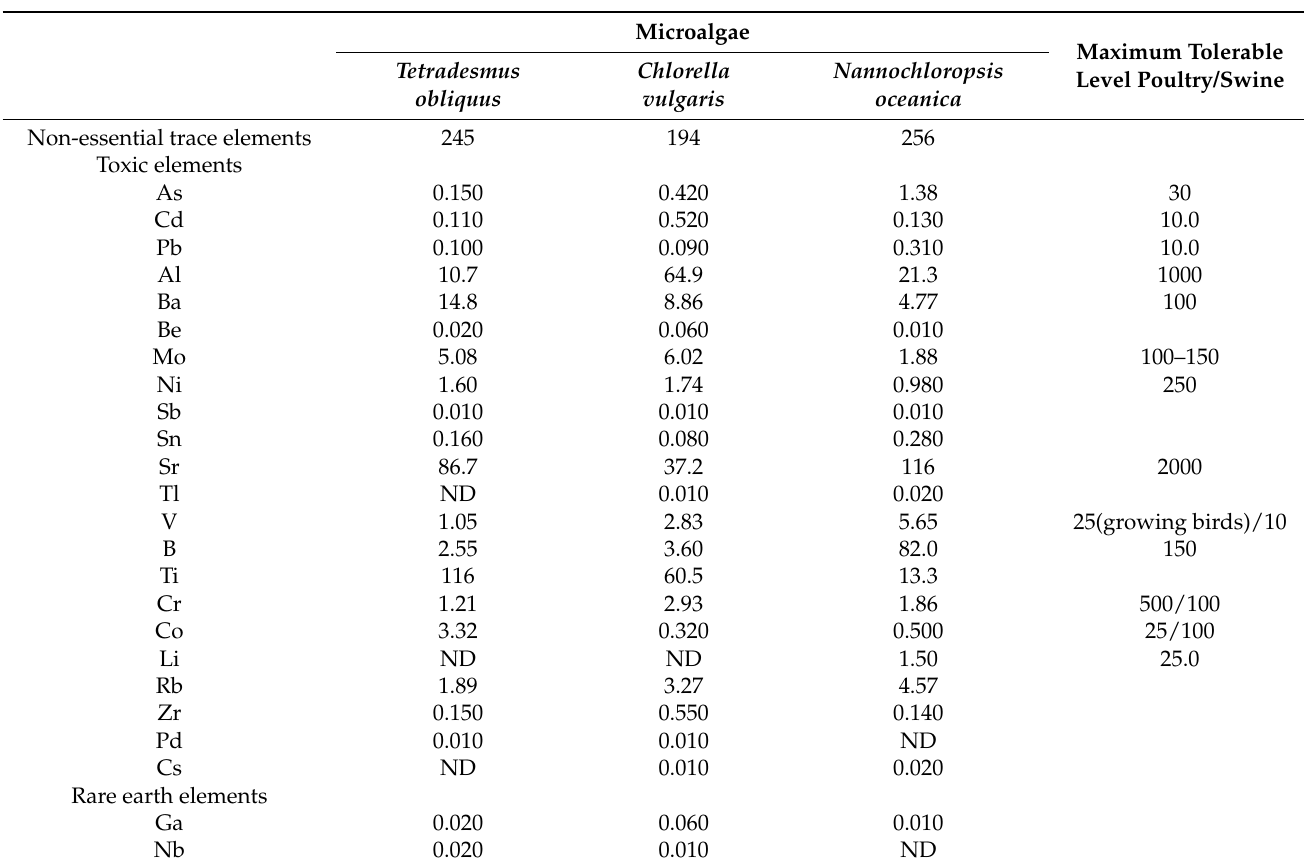
Table 6. Content of non-essential, toxic and rare earth elements in the studied microalgae species (mg kg − 1 dry matter). Maximum tolerable levels are reproduced with permission from NRC